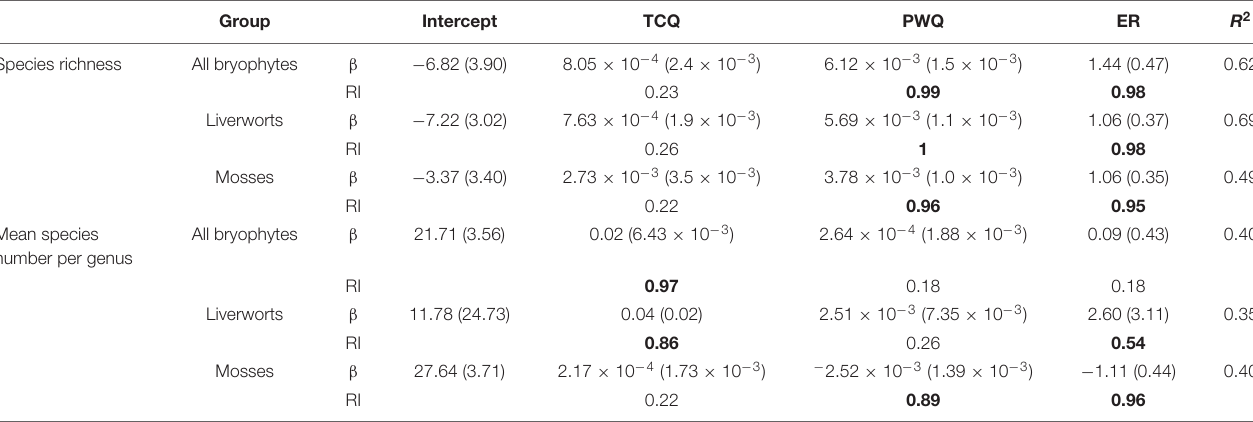
TABLE 1 | Multiple regression between species richness and diversification rate of all bryophytes, liverworts and mosses at province level (response variables) and the average temperature of the coldest season (TCQ), the precipitation of the warmest season (PWQ), and the elevational range (ER) showing the estimated coefficients (ß), standard error, relative importance (RI) and R 2